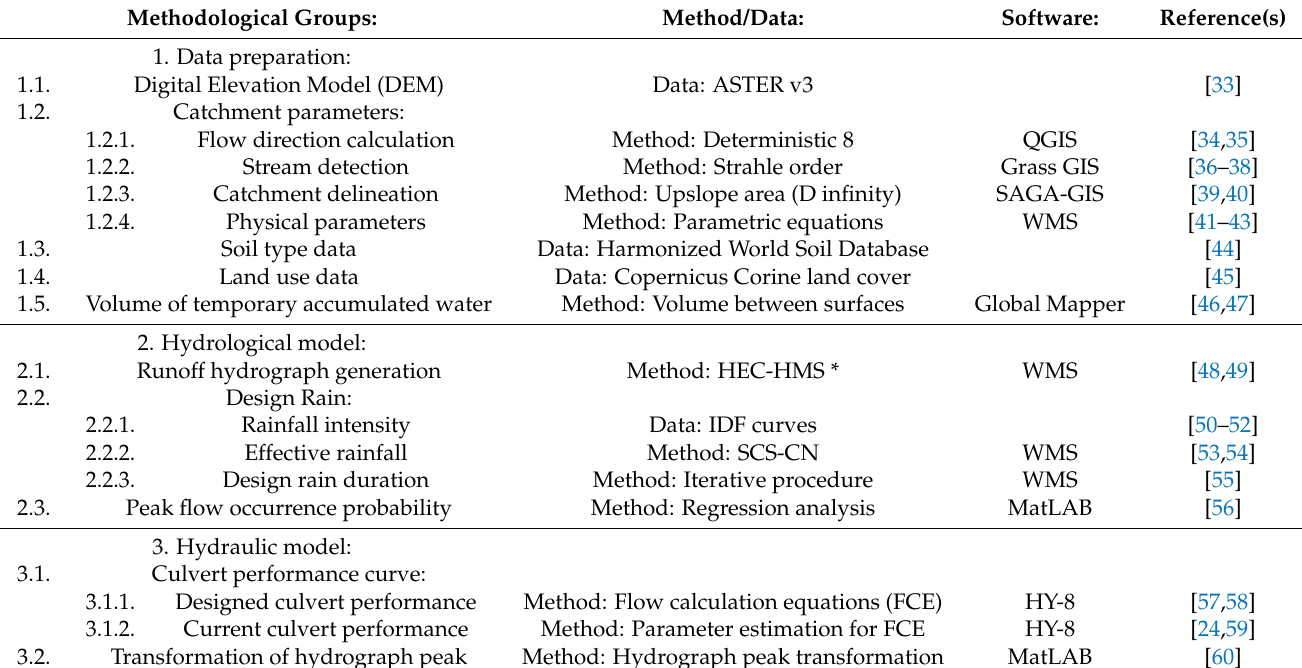
Table 2. Systematized presentation of methods and materials of the hydrological–hydraulic